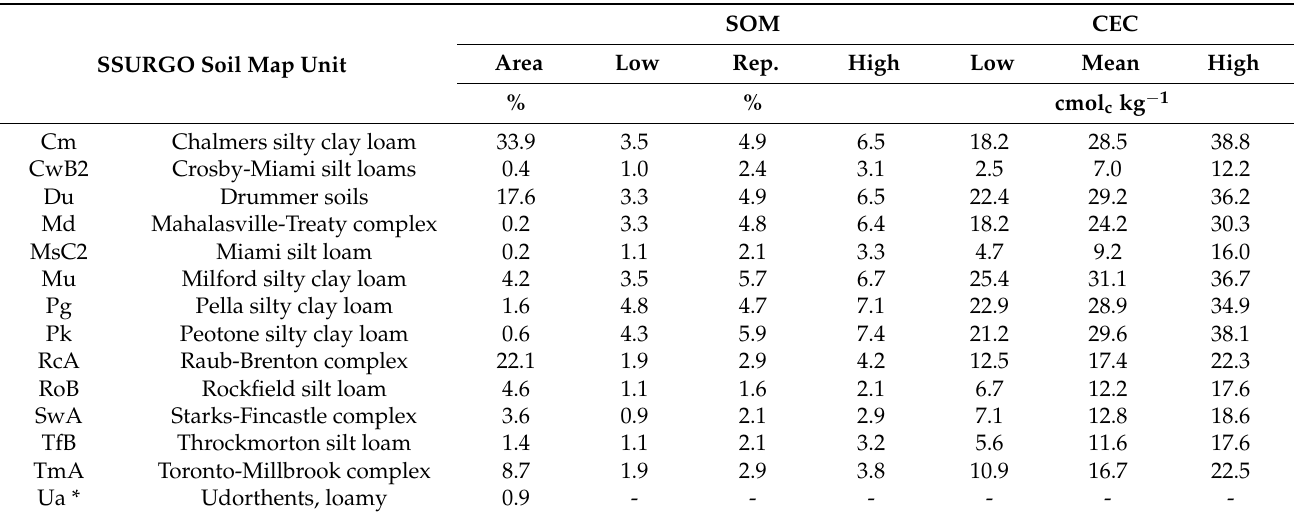
Table 1. The soil survey geographic (SSURGO) soil organic matter content (SOM) and cation exchange capacity (CEC) low, representative (Rep.), mean, and high values for 0–10 cm based on the spline function. Data is for the ACRE study